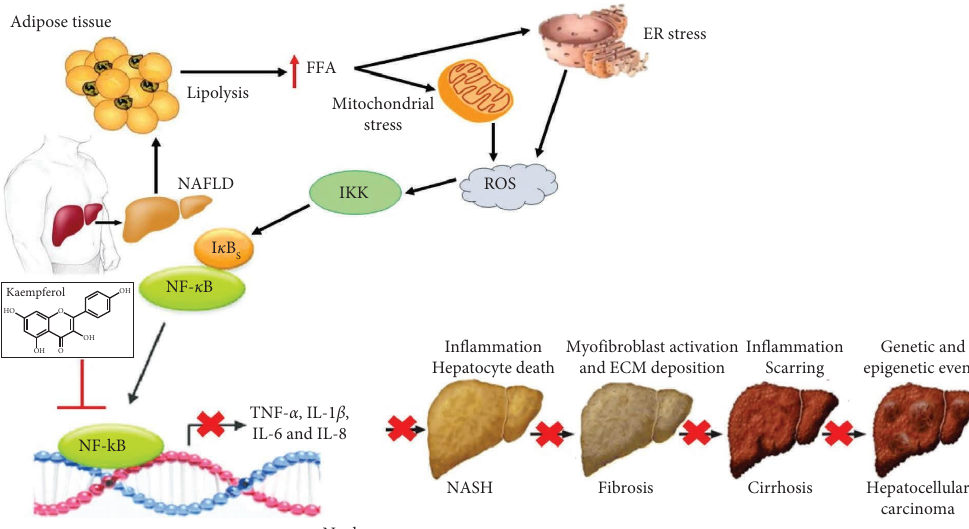
Figure 8: A proposed schematic diagram illustrating the mechanism of the efect of kaempferol on the NF- κ B signaling pathway in NAFLD. Inhibition ( ⟞